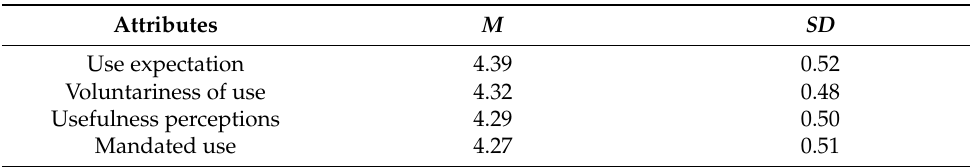
Table 1. Voluntariness Innovation Metrics ( n = 334).